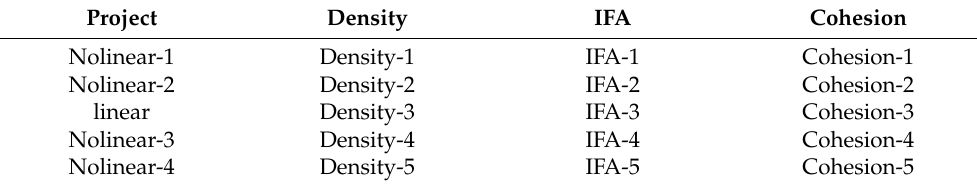
Figure 29. Physical and mechanical parameters change curve with depth. ( a ) Density, ( b ) IFA, ( c ) cohesion. Table 13. Working condition name and corresponding physical and mechanical parameters